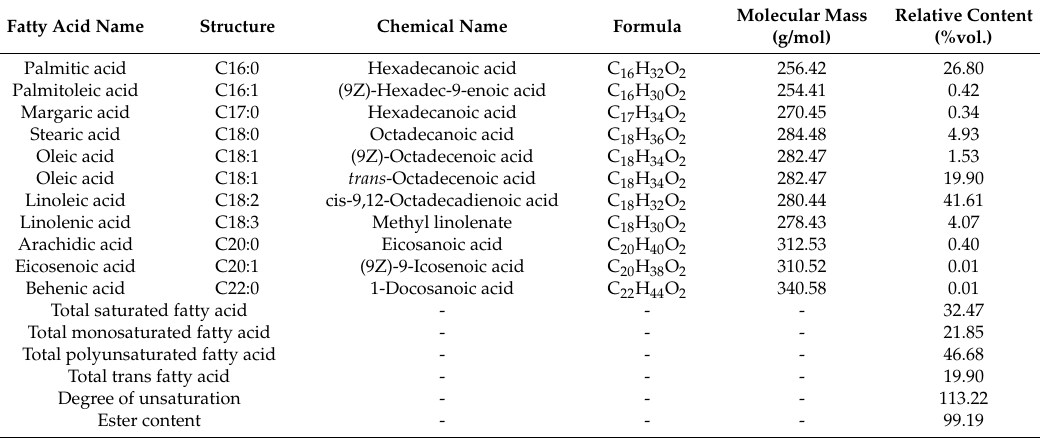
Table 4. Fatty acid composition of mandarin biodiesel (under EN 14103